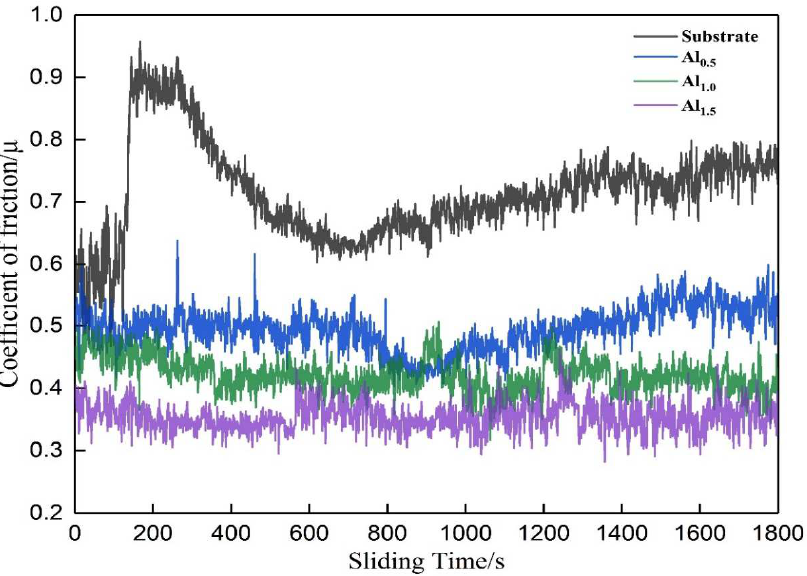
Figure 7. Coefficient of friction vs sliding time curves for the samples at room temperature under dry sliding wear test conditions.